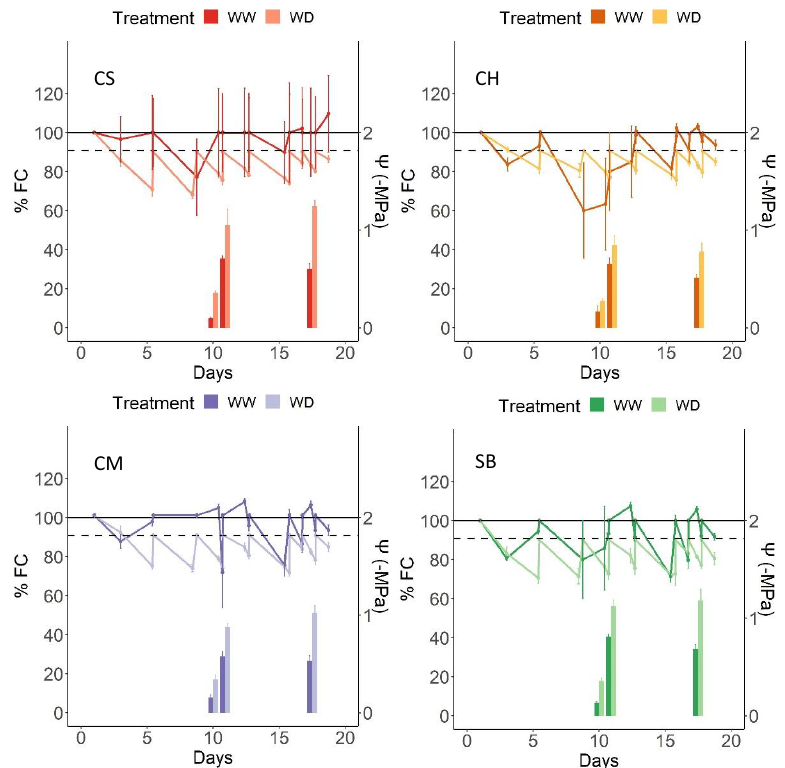
Figure 3. Water content in pots, determined by weight, for WW and WD plants, measured three times a week, along the experimental period for CM, CH, SB and CS. Also, at day 10, Ψ pre-down and Ψ stem and, at day 17, Ψ stem are represented by paired bars. Light colour indicates WW and dark colour indicates WD. Upper horizontal line represents 100% of FC, and dotted line represents 90% of FC. Error bars represents